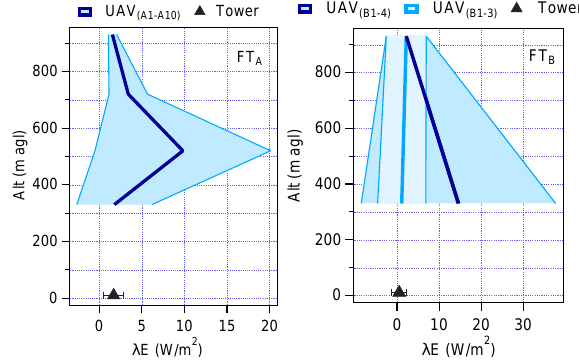
Fig. 11. Vertical flux profiles of time-integrated λE averaged for each altitude during (a) flux legs A1–A10 during FT A and (b) runs B1 to B4 and B1 to B3 for FT B . Tower data averaged for the time period of the 330ma.g.l. flux runs are also shown. Shaded regions and error bars indicate 1 σ .